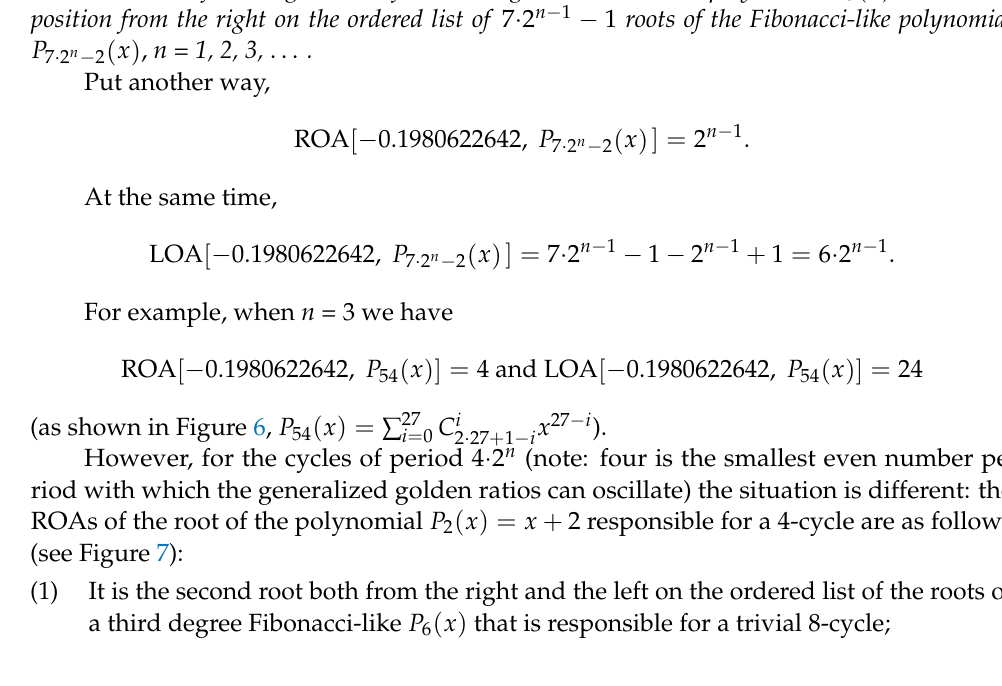
riod with which the generalized golden ratios can oscillate) the situation is different: the ROAs of the root of the polynomial P 2 ( x ) = x + 2 responsible for a 4-cycle are as follows (see Figure